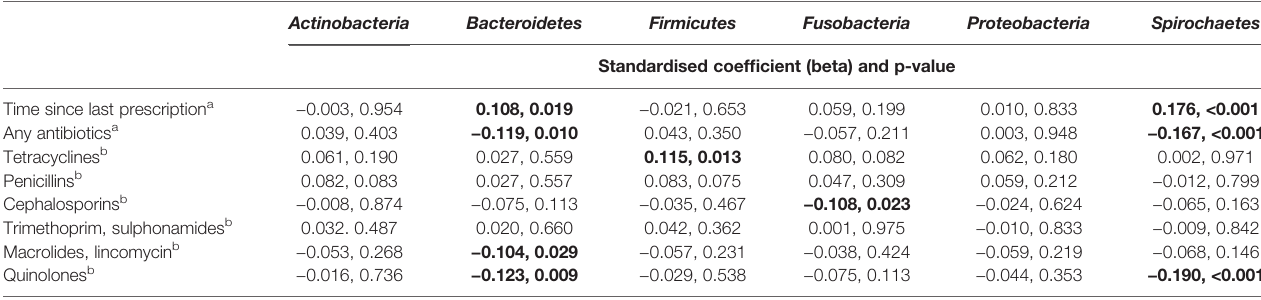
TABLE 3 | Association of antibiotic type with subgingival